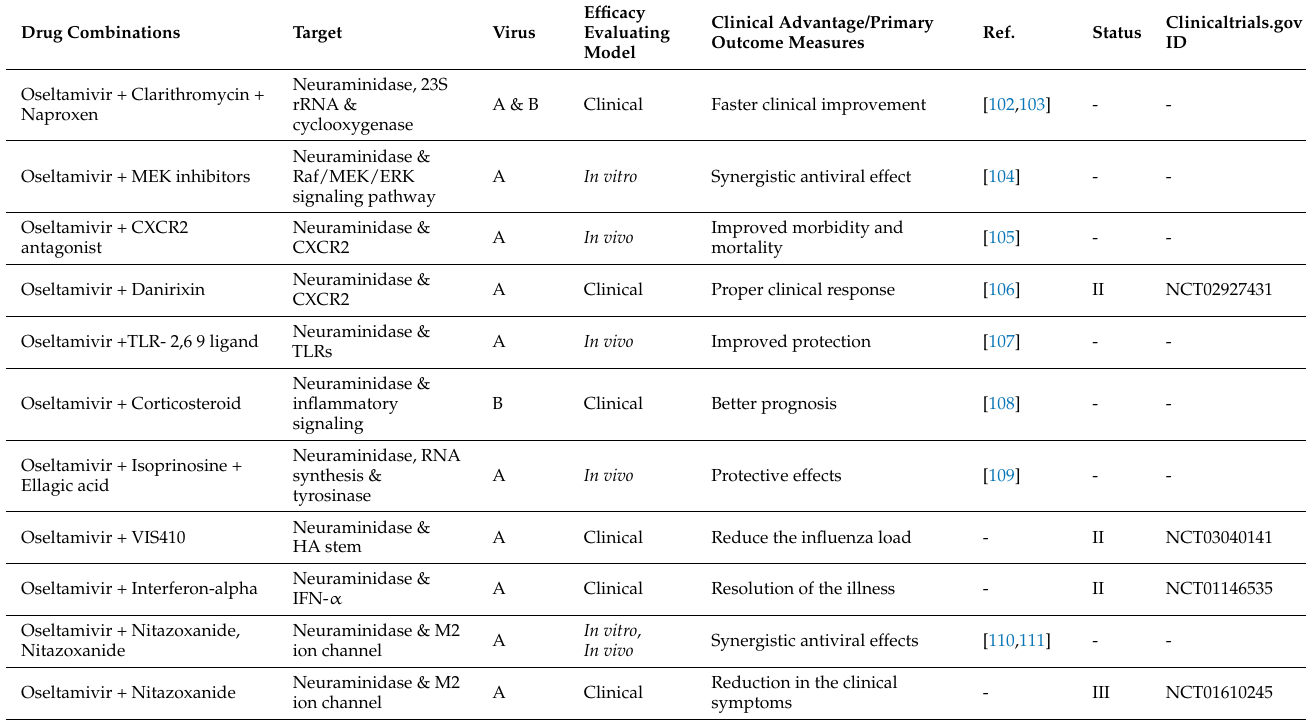
Table 5. Combination therapy targets both host and pathogen